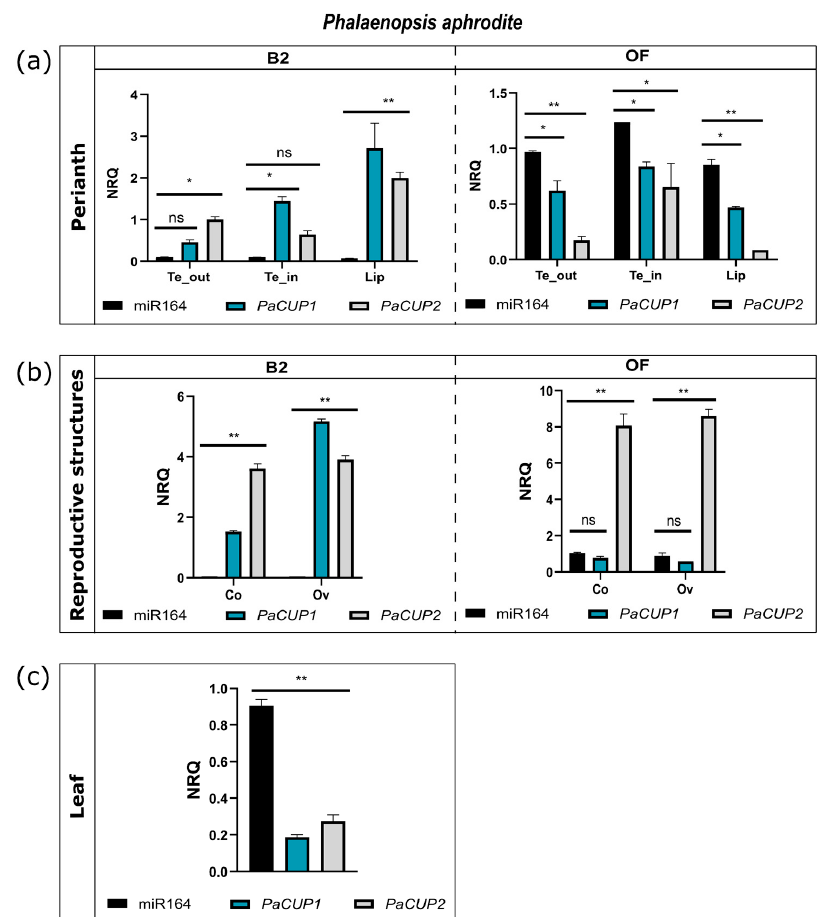
Figure 7. Expression patterns of miR164 in P. aphrodite . Comparison of the expression patterns of miR164 and PaCUP1-2 in perianth structures ( a ) and reproductive organs ( b ) of P. aphrodite at the B2 and OF developmental stages. ( c ) Comparison of the expression pattern of miR164 and PaCUP1-2 in a P. Aphrodite leaf. The expression level is reported as normalized relative quantity (NRQ). The bars represent the SEM of the biological and technical replicates. The asterisks indicate the statistically significant differences between the miR164 and CUP1-2 NRQ values. p values * < 0.0257, ** < 0.0001. The results are reported in Supplementary Data S4. Te_out, outer tepals; Te_in, inner tepals; Co, column; Ov, ovary.